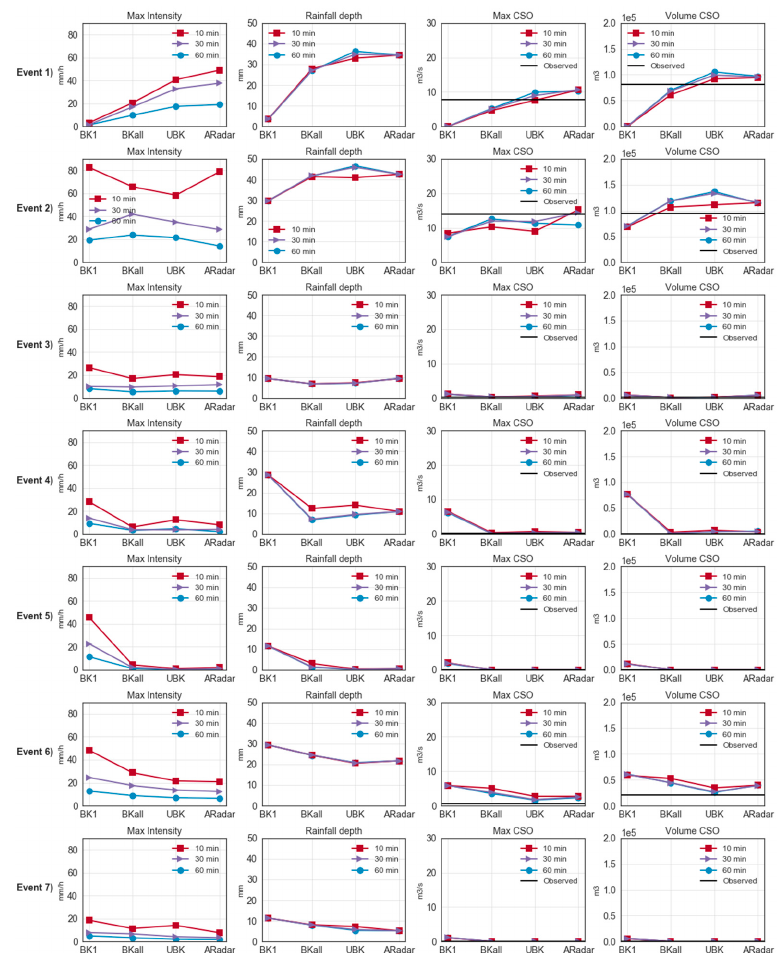
Figure A1. Rainfall input and urban drainage response of the municipality of Valkenswaard during three of the selected storm events. Each graph depicts the effect of the four rainfall products, rendered at different time accumulation steps. From left to right: maximum rainfall intensity, accumulated rainfall depth, maximum CSO flow and accumulated CSO volume.